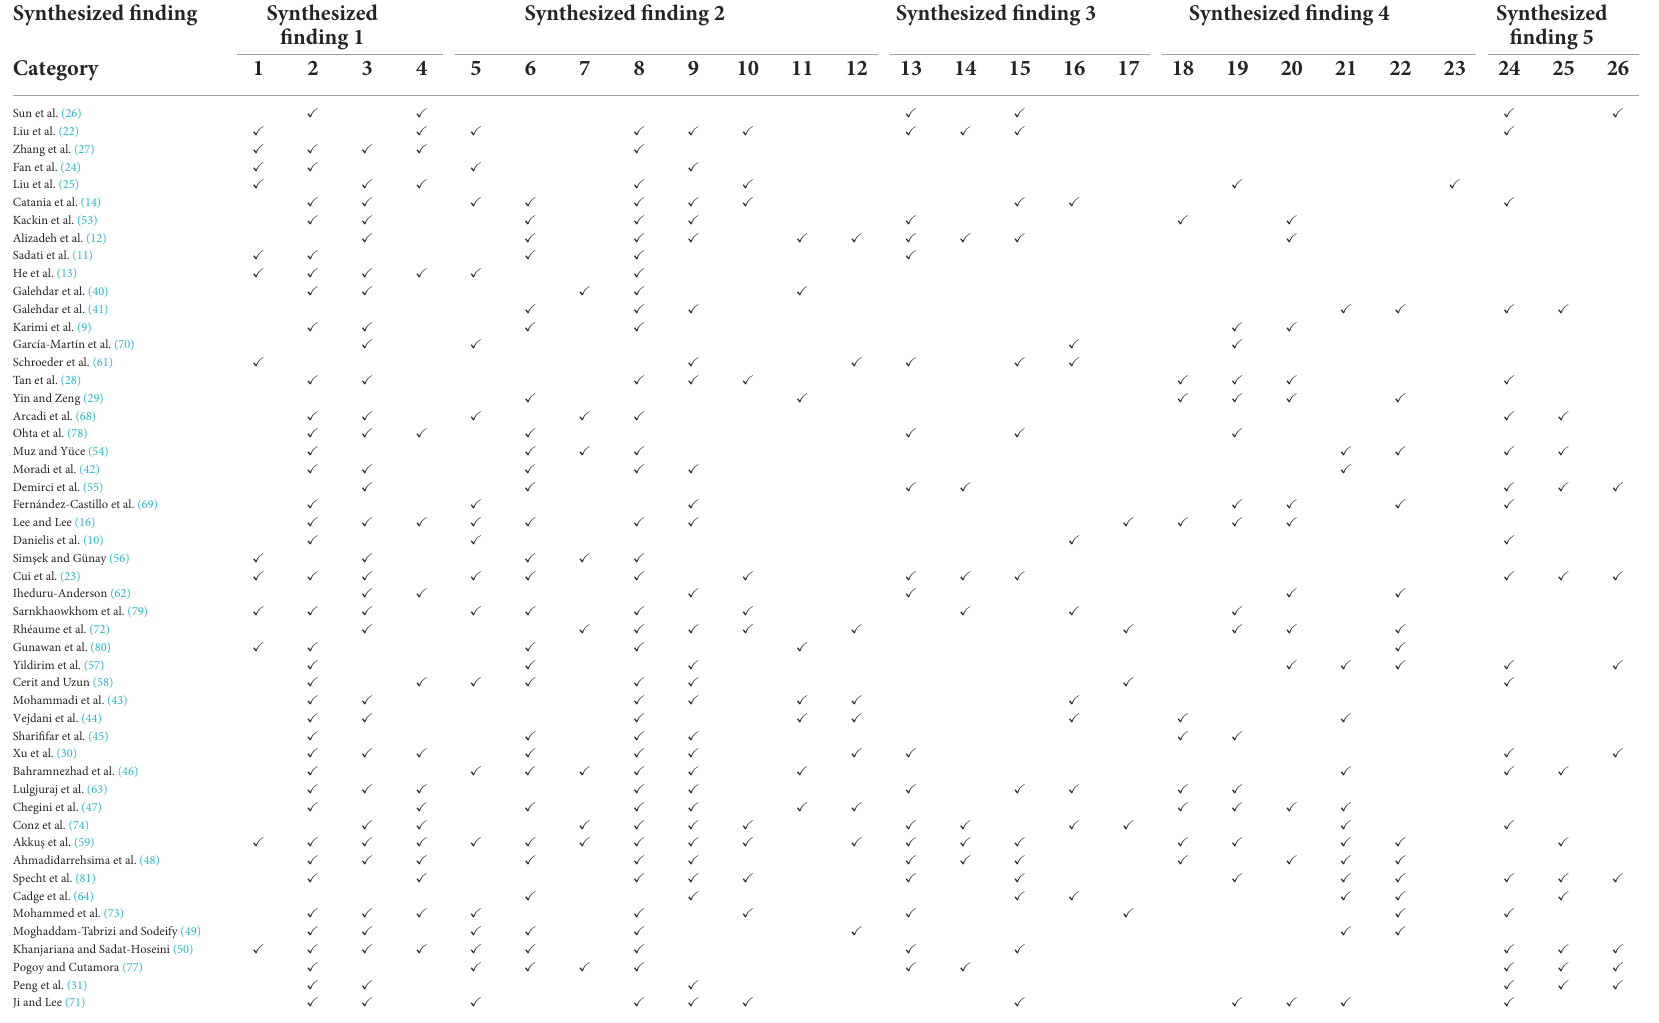
TABLE 4 Meta-synthesis of